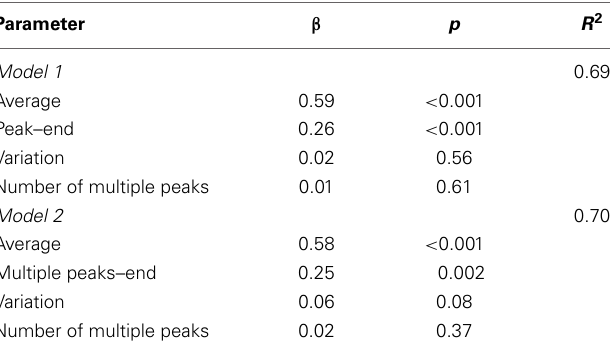
Table 3 | Regression coefficients of a selection of distinct parameters of moment-to-moment experience for their influence on the overall evaluation ( N =